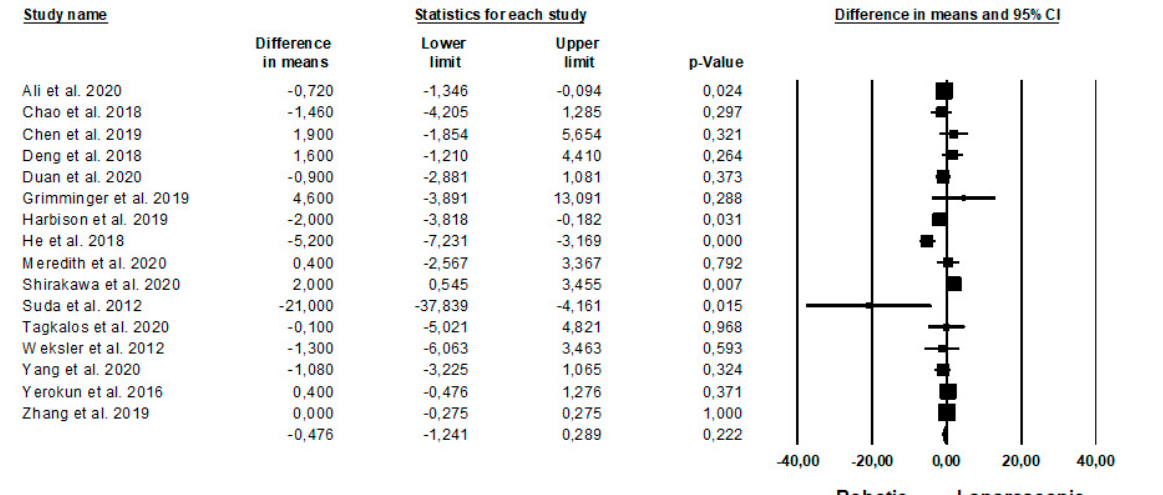
Figure 5. Robotic versus laparoscopic surgery: length of hospital stay.